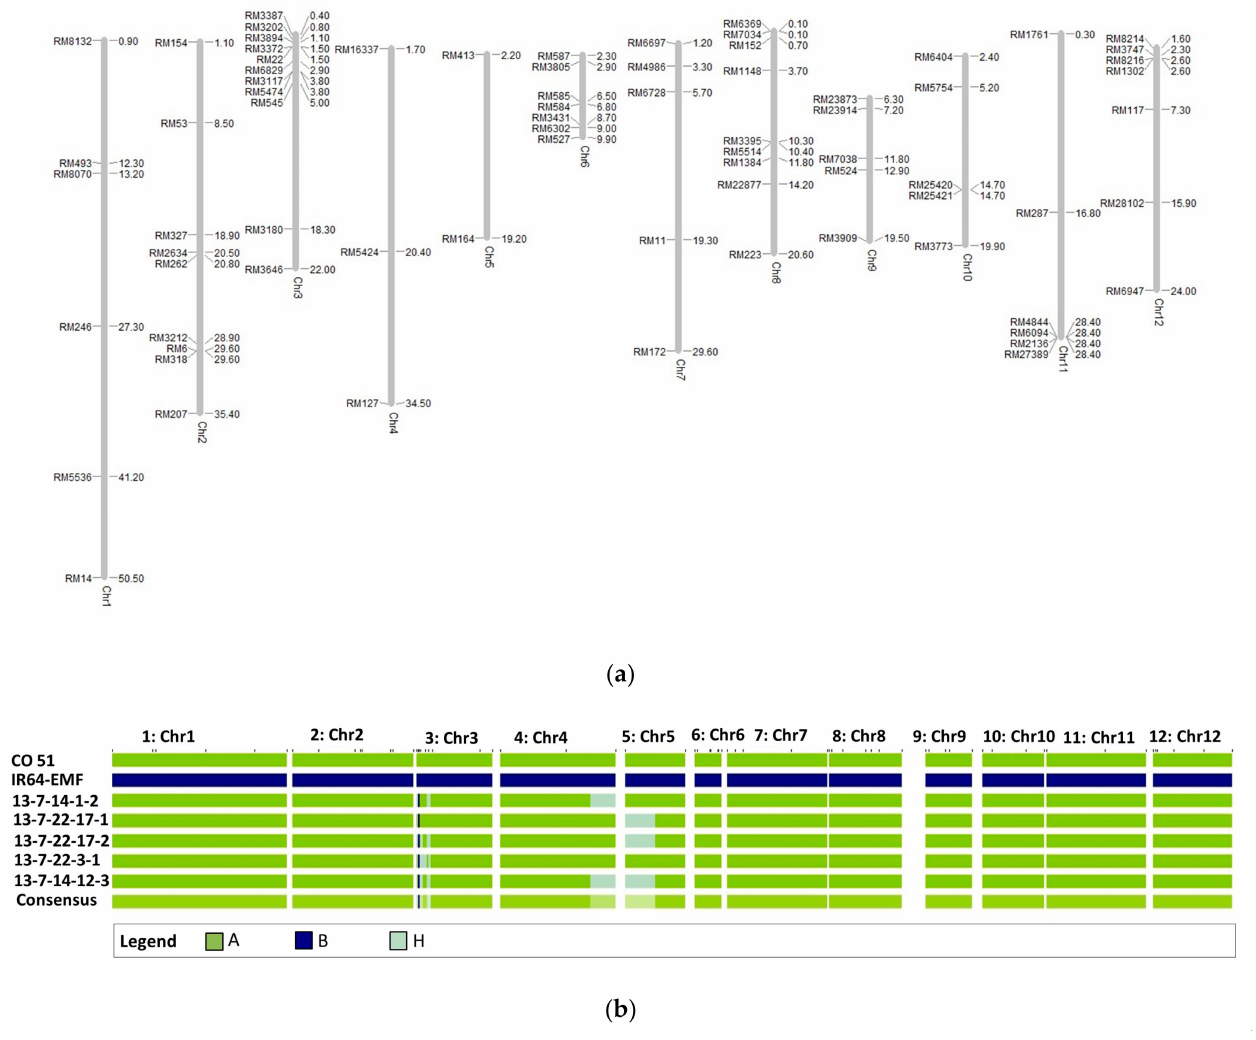
Figure 4. Graphical representation of 75 genome-wide SSR markers used for genotyping ( a ) and their allelic status in the 5 superior BC 3 F 1 plants ( b ). Green shade area represents recurrent parent genome; dark blue represents donor genome; light blue shade represents the heterozygous nature of the